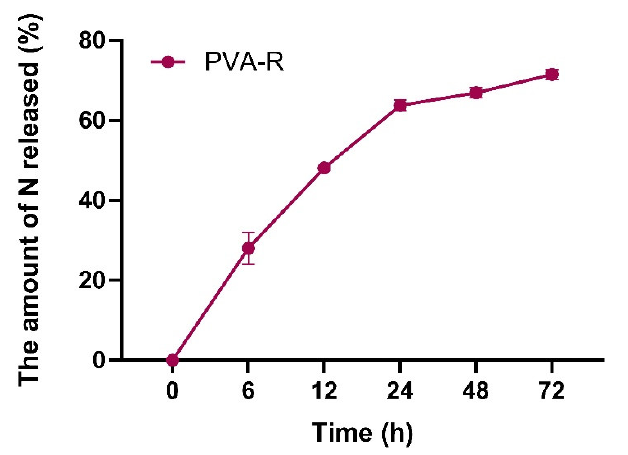
Figure 3. In vitro drug release profiles of N-loaded NPs (prepared with PVA-R surfactant). Results were represented as mean ± SD, n = 3.